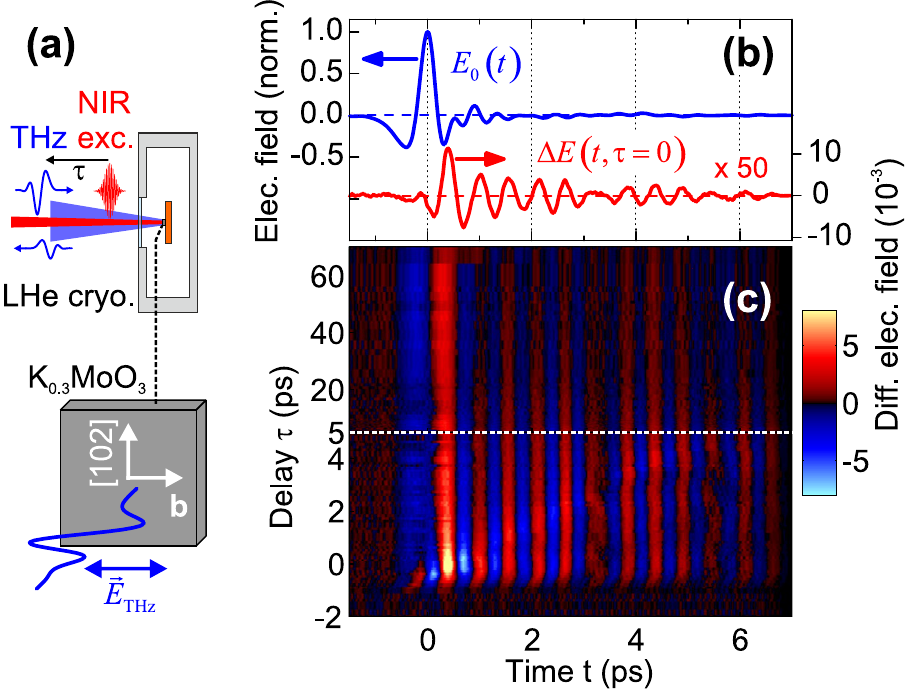
Figure 2. Time-domain field response to optical excitation. ( a ) Experimental OP-TP reflection geometry. ( b ) Detected temporal electric fields ( T = 50 K, pump fluence F ex = 550 μ J cm − 2 ): Reference field E 0 ( t ) (reflected signal without optical excitation); differential field change Δ E ( t , τ ) for pump-probe delay τ = 0. ( c ) Full 2D map of Δ E ( t , τ ). Note that the data is plotted with two different scales for the ranges τ ∈ [ − 2, 5] ps and τ ∈ [5, 70] ps,